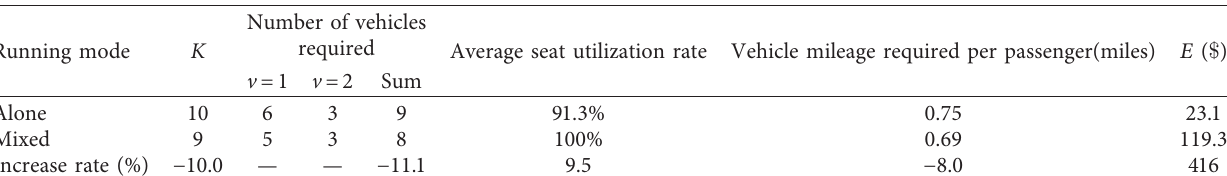
Table 12: Comparisons of two running modes in the optimal service area.